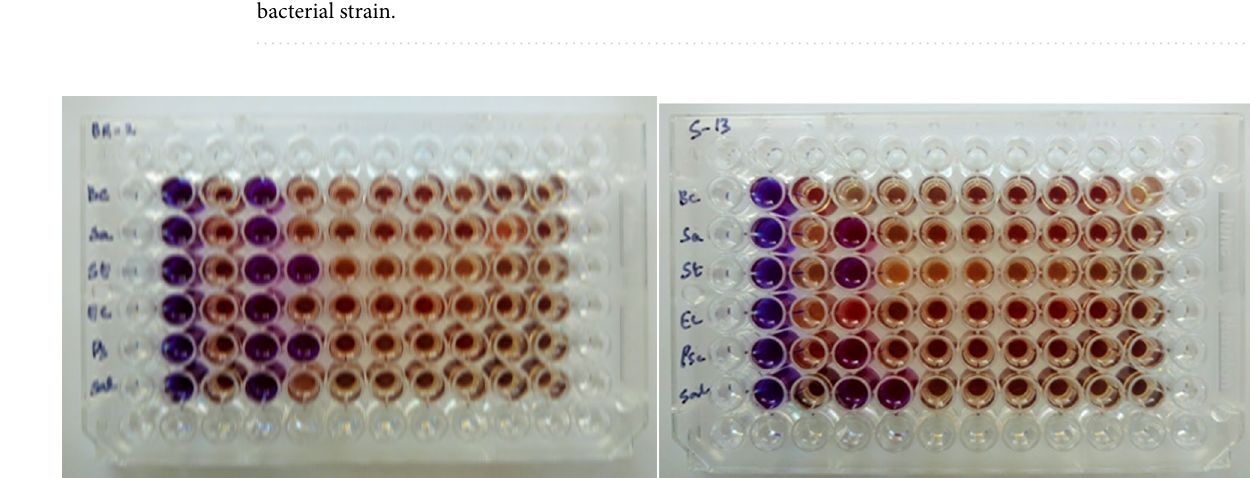
Table 1. Minimal inhibitory concentration (MIC) determination of BR-2 and S-13 pectin extracts against bacterial strain.